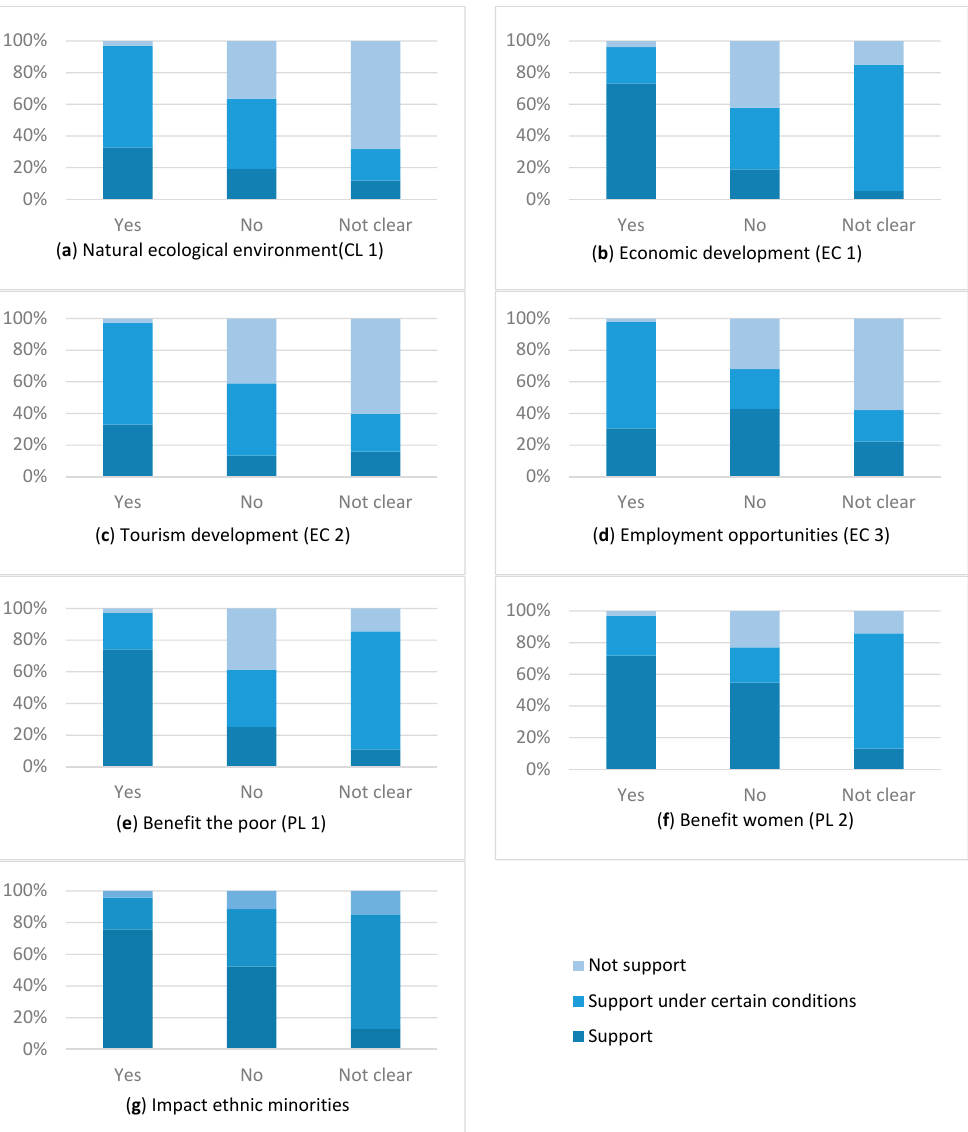
Figure 2. Descriptive analyses of the association between resident attitudes toward NNP and perceptions of the SIA. ( a ) Natural ecological environment(CL 1), ( b ) Economic development (EC 1), ( c ) Tourism development (EC 2), ( d ) Employ- ment opportunities (EC 3), ( e ) Benefit the poor (PL 1), ( f ) Benefit women (PL 2), ( g ) Impact ethnic minorities.